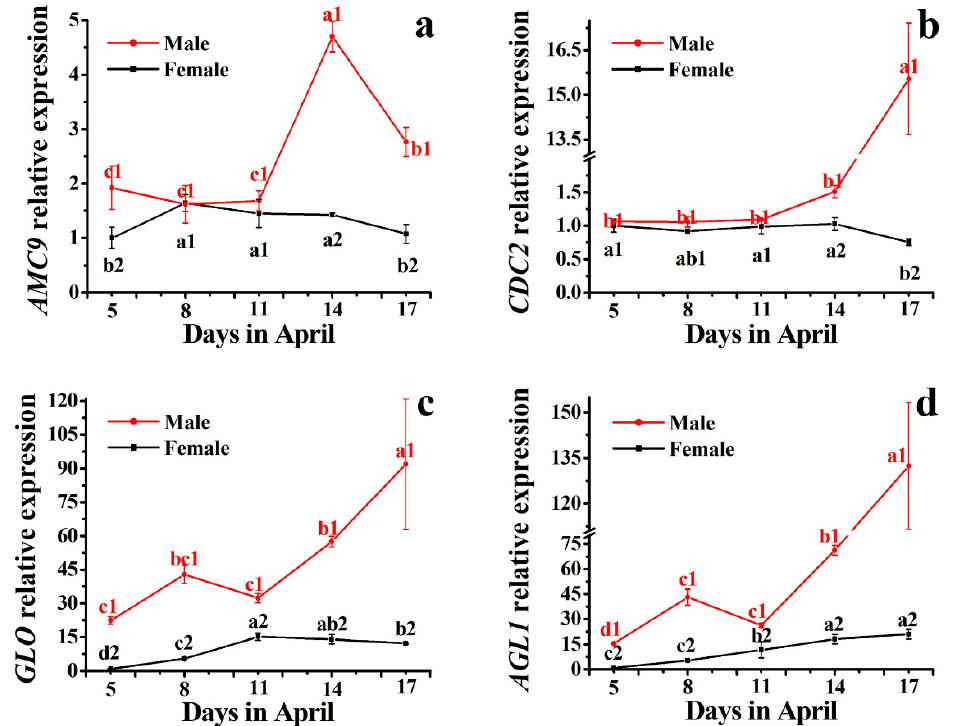
Figure 11. RT-qPCR analysis of the expression levels of PCD-related genes correlated with female floral organs during di ff erent developmental stages. ( a – d ) represent the relative expression levels of the genes homologous to AMC9 , CDC2 , GLO , and AGL1 . The value on April 5, 2017 in female floral buds was set to 1.0. Data are expressed as the mean ± standard error of three replications. Red and black letters indicate a significant di ff erence among developmental stages for male and female floral buds, respectively, based on Tukey’s multiple comparison test at the P < 0.05 significance level. Di ff erent numbers indicate a significant di ff erence between male and female flowers at each developmental stage based on an independent T -test at the P < 0.05 significance level.